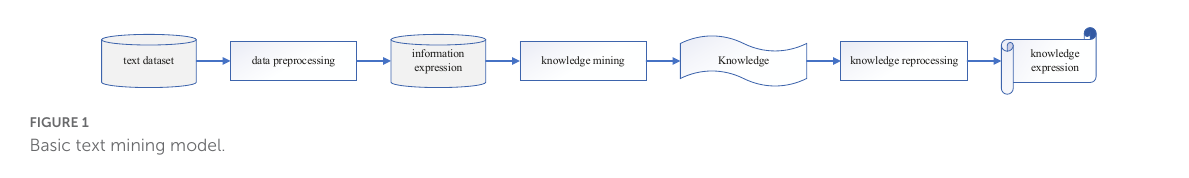
TABLE 1 Examples of subjective expression recognition in financial reports. Sentence